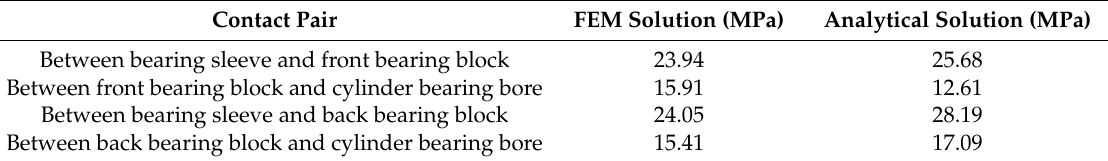
Table 5. Comparison of contact pressure between analytical method and